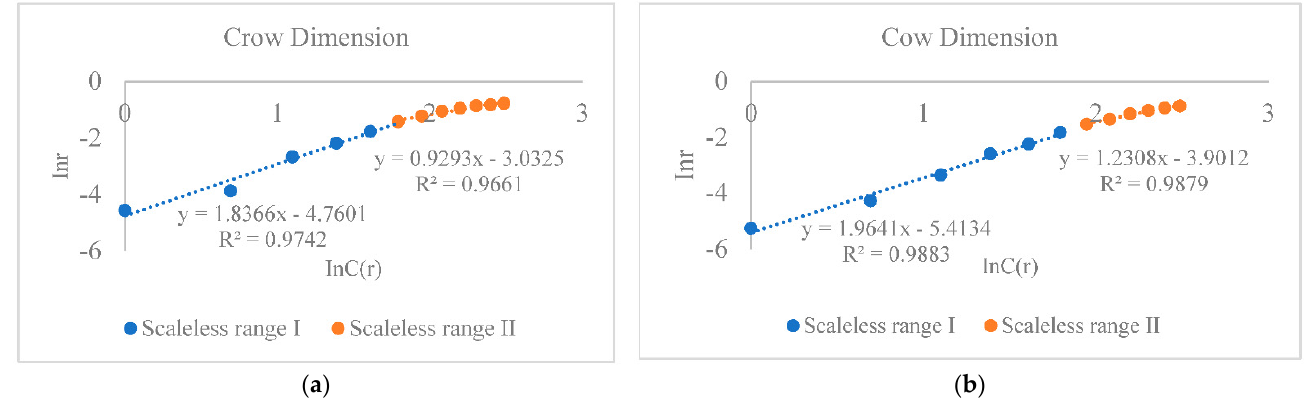
Figure 6. The log − log plot for the correlation dimension of the Fuzhou park system. ( a ) Crow dimension of park sytstem; ( b ) cow dimension of park system.